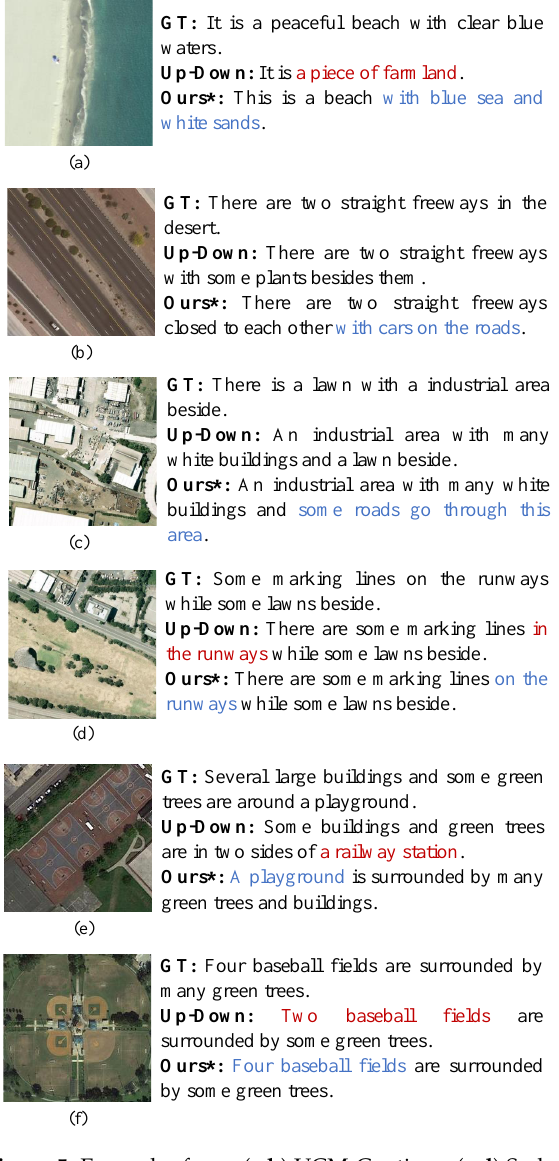
Figure 5. Examples from: ( a , b ) UCM-Captions; ( c , d ) Sydney-Captions; and ( e , f ) RSICD. The output sentences were generated by (1) one selected ground truth (GT) sentence; the (2) Up-Down model; and (3) our proposed model without SCST (Ours*). The red words indicate mismatches with the generated images, and the blue ones are precise words obtained with our